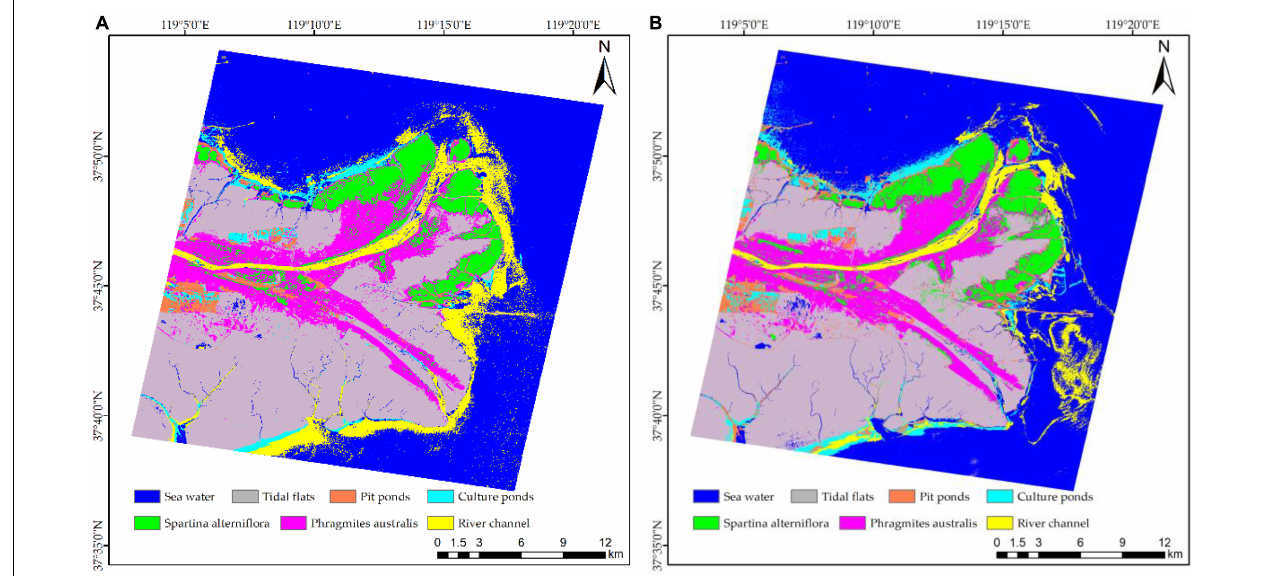
FIGURE 12 | Results of different classification methods based on joint features using October 2017 data: (A) Support vector machine classification; (B) Maximum likelihood classification.